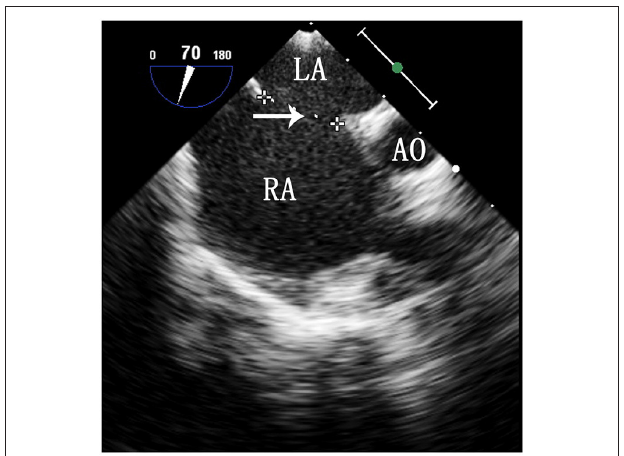
FIGURE 3 | TEE image of the ASD on a two atrial chamber section. LA, left atrium; RA, right atrium; Ao, aorta. The arrow indicates the maximum diameter of the ASD.